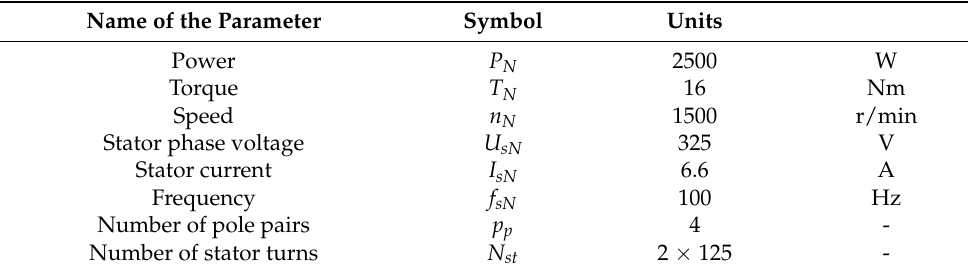
Table A1. Rated parameters of the tested PMSM. Name of the